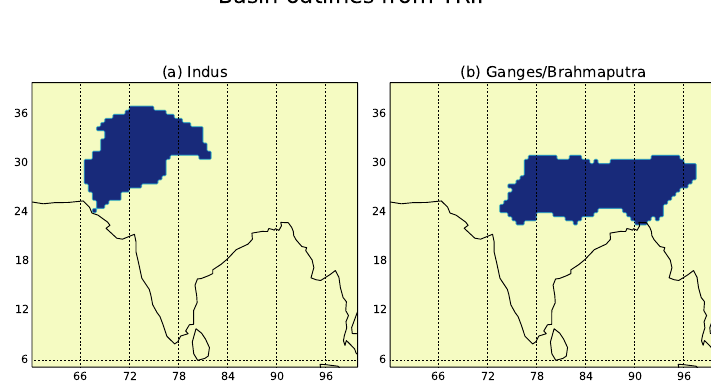
Figure 4. The outline of the basins within the TRIP model; Indus (a) and Ganges–Brahmaputra (b) .